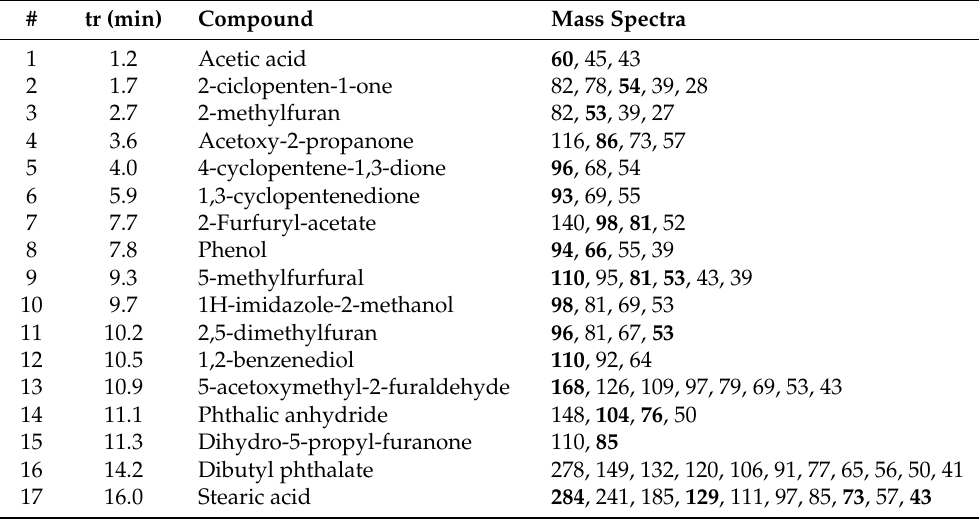
Table 4. Main pyrolysis products detected in the pyrogram of sample P reported in Figure 6b. The most intense peaks are reported in